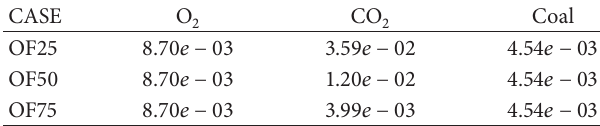
Table 2: CFD simulation flow rates (kg/s). CASE O